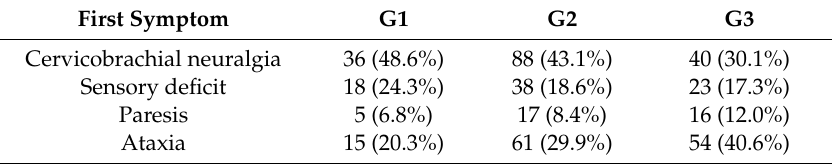
Table 3. Analyzing the first presenting symptom in relation to the age